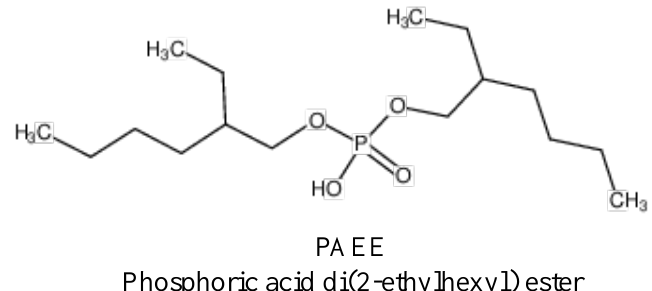
Figure 4. Phosphoric acid di(2-ethylhexyl) ester (PAEE). PAEE is often used in lipid/polymer membranes for taste sensor as a lipid.